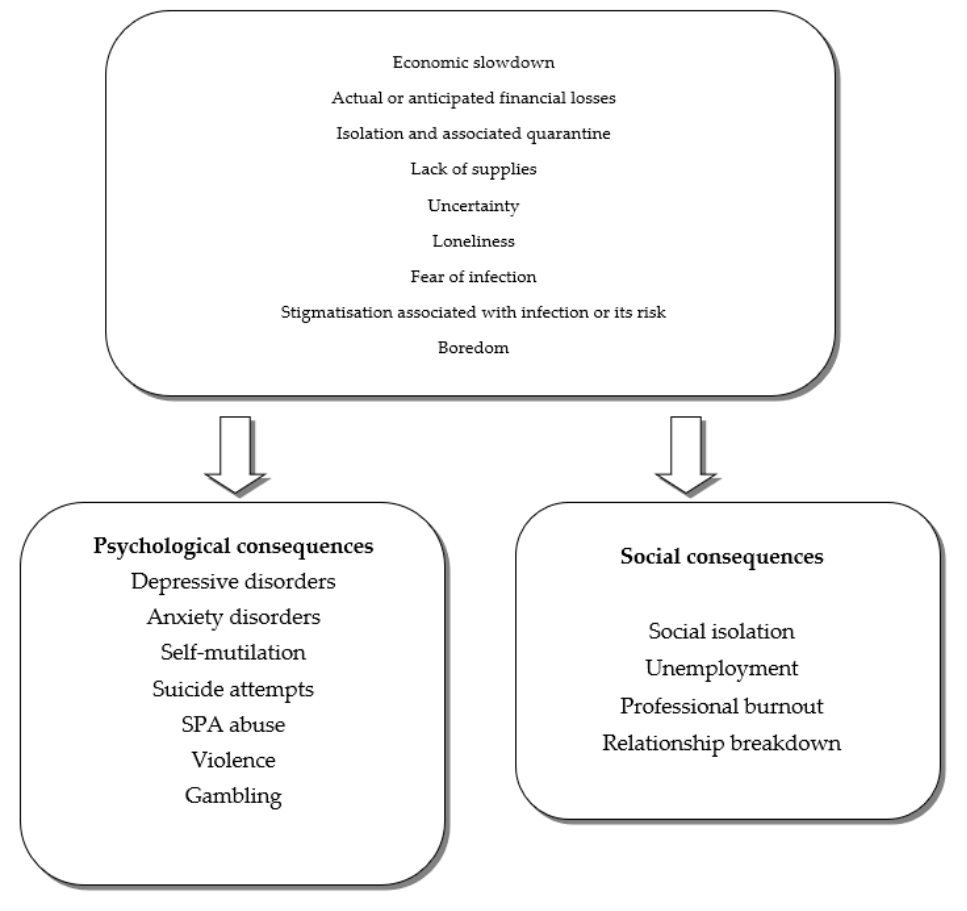
Figure 1. The factors that are a source of stress during the SARS-CoV-2 epidemic and their possible psychological and social consequences [7].